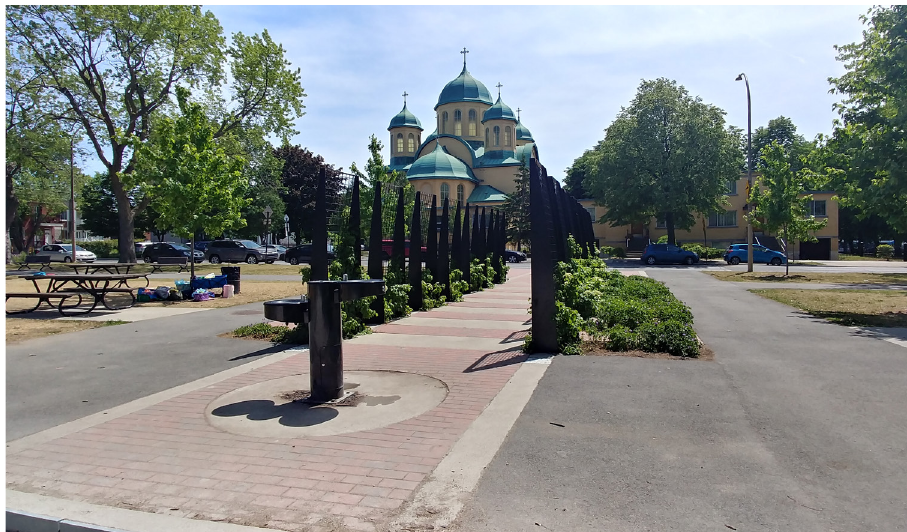
Fig. 2. Ukrainian tunnel of love (Ukrainian symbol) in the Parc de l’Ukraine